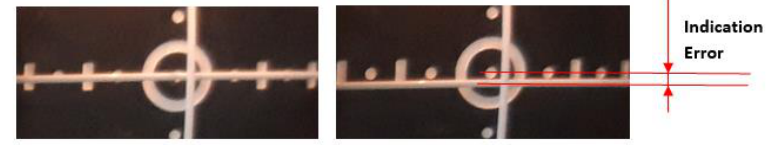
Figure 12. Indication error caused by ILS/GP disturbance.